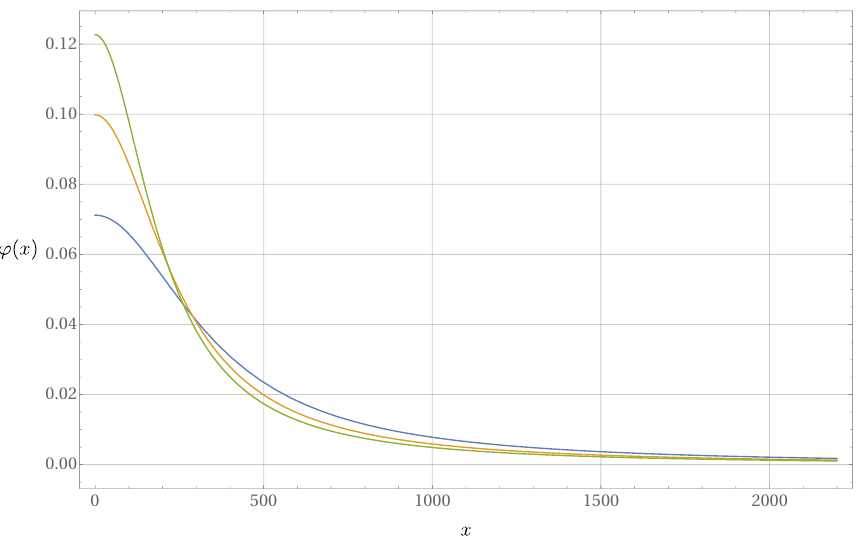
Figure 2 . The blue curve is the pro(cid:12)le of the bounce solution obtained for the potential (3.2) with (cid:21) 6 = 0 and (cid:21) 8 = 0, i.e. in the absence of new physics. The yellow curve is the pro(cid:12)le of the bounce solution for (cid:21) 6 = (cid:0) 0 : 03 and (cid:21) 8 = 0 : 03, while the green one is the pro(cid:12)le of the bounce obtained for (cid:21) 6 = (cid:0) 0 : 04 and (cid:21) 8 = 0 : 04. Note that with increasing values of the couplings the center of the bounce ’ (0) becomes larger while the size